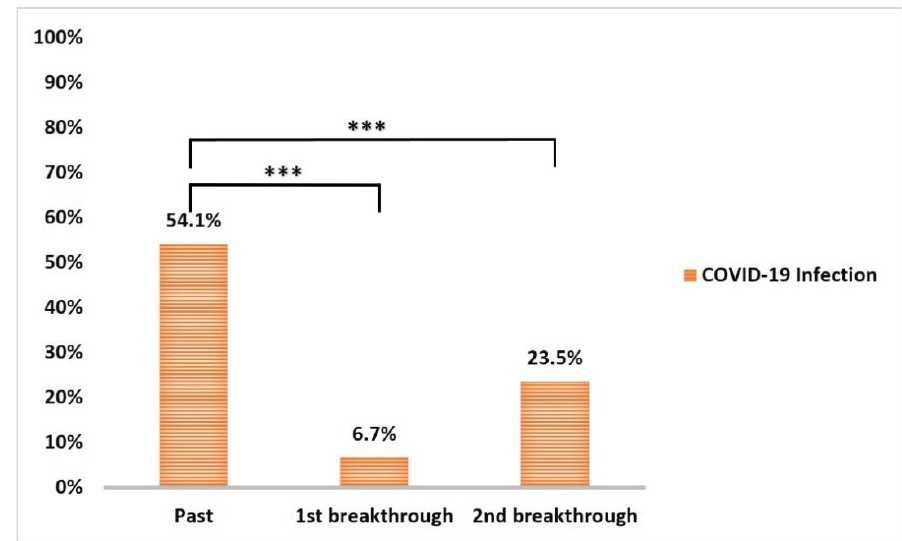
Figure 7. Frequency of past COVID-19 infection (prior to vaccination), 1st breakthrough COVID-19 infection after the 1st dose (between two doses of vaccination), and 2nd breakthrough COVID-19 infection after the 2nd dose of vaccine. Data were analyzed by McNemar Test, and significant difference is defined as *** p < 0.001.